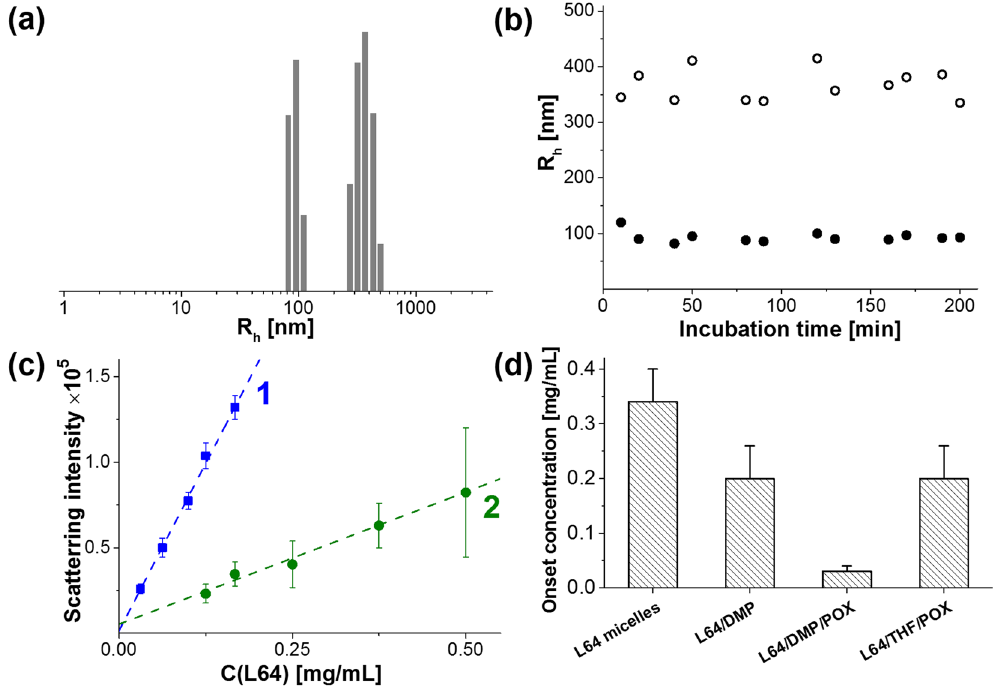
Figure 2. Characterization of the POX-containing dispersions. ( a ) Size distribution of the dispersion prepared from POX solution in DMP. ( b ) Stability of hydrodynamic radii of two fractions of L64/POX/DMP dispersions over time (L64/DMP/POX = 1:2.7:0.3 by mass, Pluronic L64 concentration 0.25 mg/mL, PBS, 37 °C). ( c